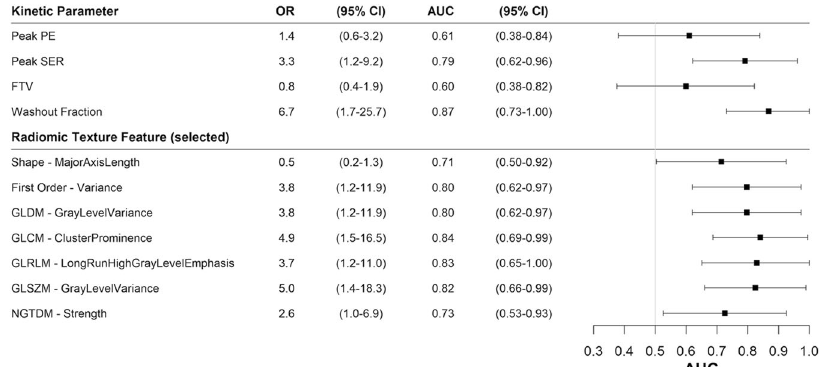
Fig. 4 Performance of DCE-MRI kinetics and radiomics features for distinguishing lesions with different microvessel densities. Odds ratios (ORs) and forest plot of area under the receiver operating characteristic curve (AUC) for predicting high microvascular density (MVD) are shown for all kinetic parameters and selected radiomic texture features. ORs are scaled to correspond to differences per 1-standard deviation increase. The error bars represent 95% con fi dence intervals (CIs). The texture feature with the strongest association with MVD in terms of AUC is shown for each radiomic feature category. See Table 3 and Supplementary Table 2 for more